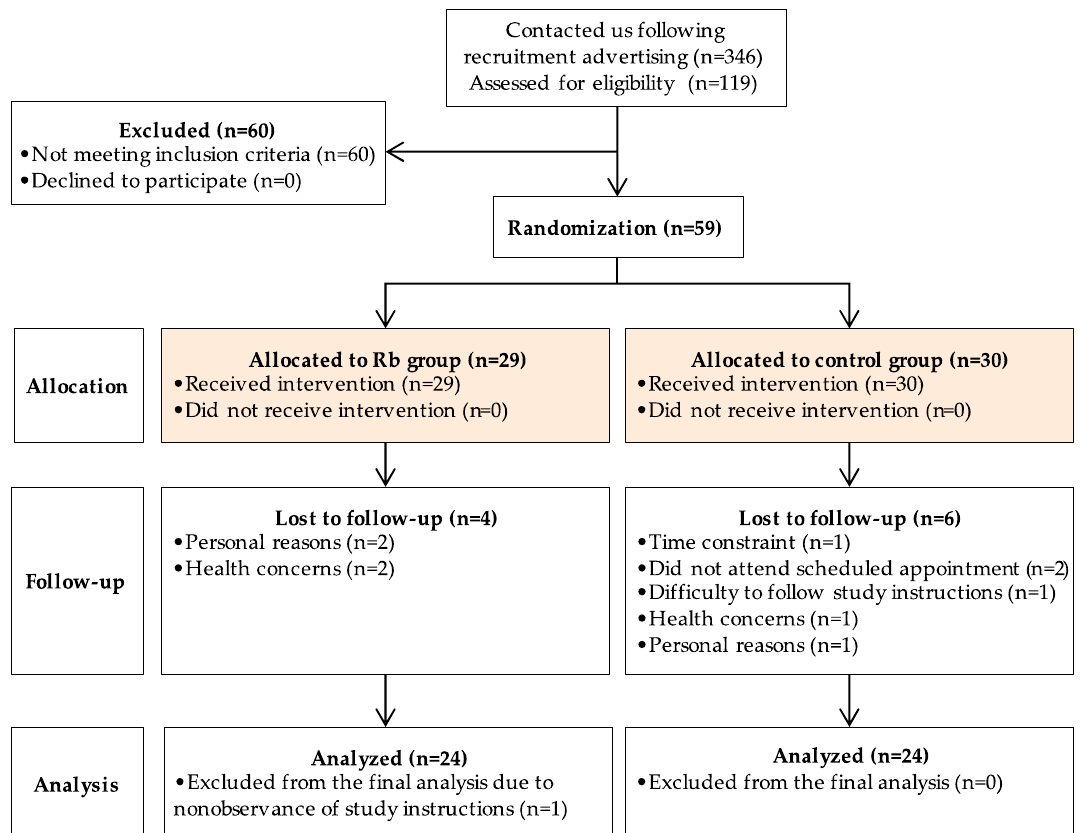
Figure 1. Patient flow diagram for recruitment, randomization, and data collection.